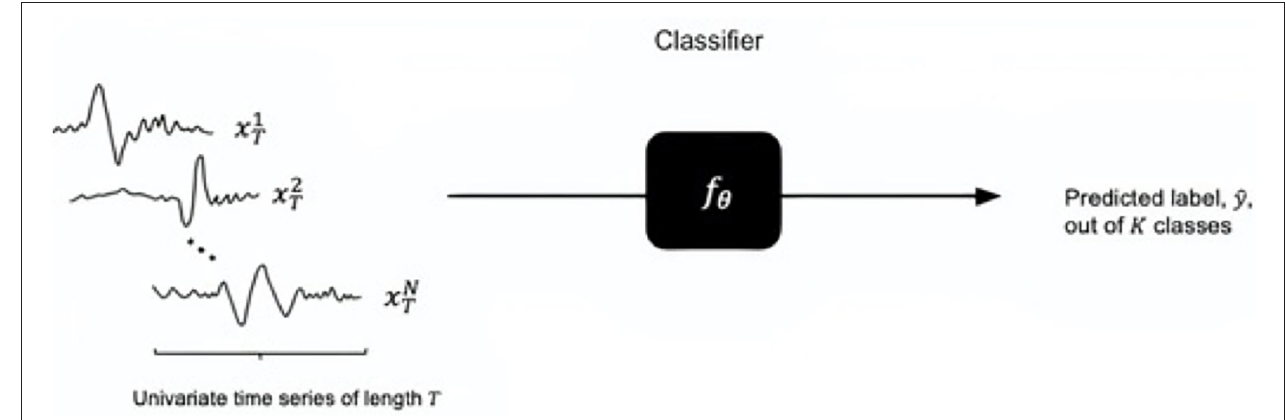
FIGURE 1 | Time series classification task (for univariate time series): a trained classifier with parameters takes the input of time series of length T and outputs a predicted class out of K classes. The input size is denoted by